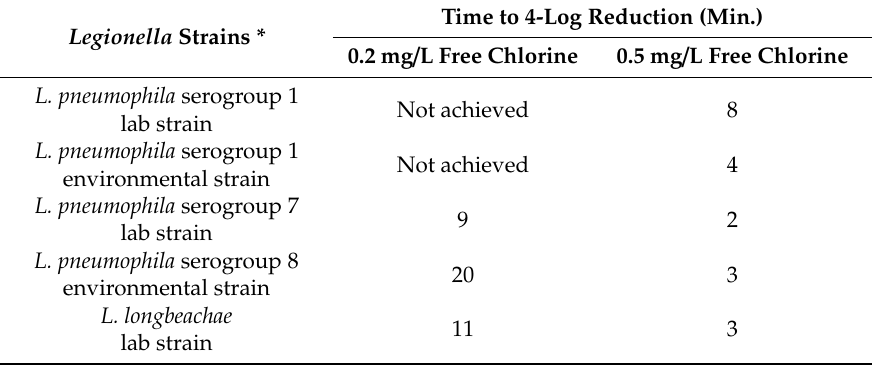
Table 1. Time to 4-log reduction of various Legionella strains at two di ff erent concentrations of free chlorine. Adapted from [77].